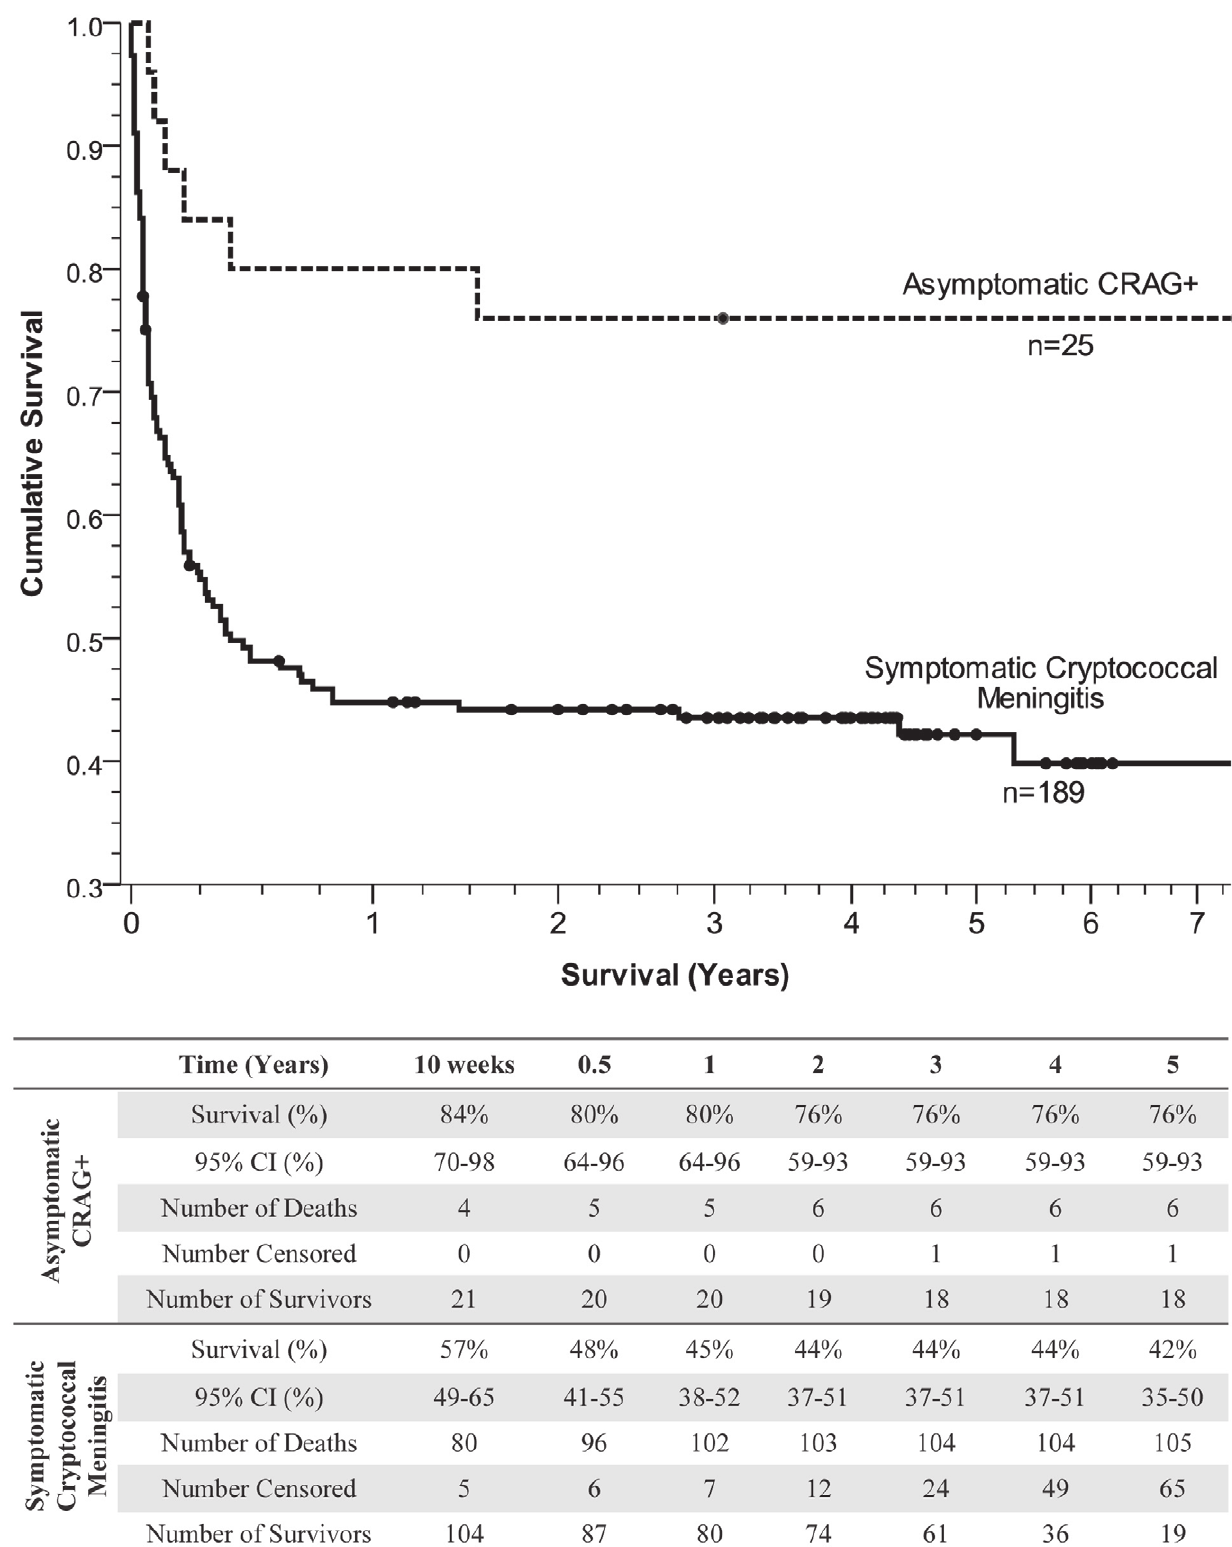
Figure 1. Long term survival among HIV-infected persons with cryptococcosis in Uganda. The Kaplan-Meier survival curve displays the long term survival of 25 asymptomatic persons who tested positive for serum cryptococcal antigen (CRAG + ) treated with fluconazole and ART compared to 189 symptomatic patients with cryptococcal meningitis (CM) treated with amphotericin B induction and then fluconazole consolidation therapy and then ART. Diamonds represent censored data. Persons were right-hand censored if they were still living at the time of analysis (n=82), if